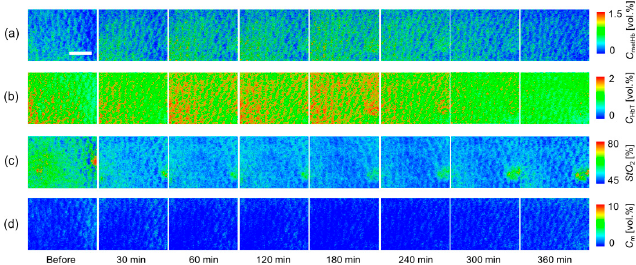
Figure 4. Typical sequential images of ( a ) C metHb , ( b ) C HbT , ( c ) StO 2 , and ( d ) C m obtained from rat dorsal skin before and after the administration of NaNO 2 at dose of 50 mg/kg. A scale bar (white line in the C metHb image for before) indicates 2.0 mm.